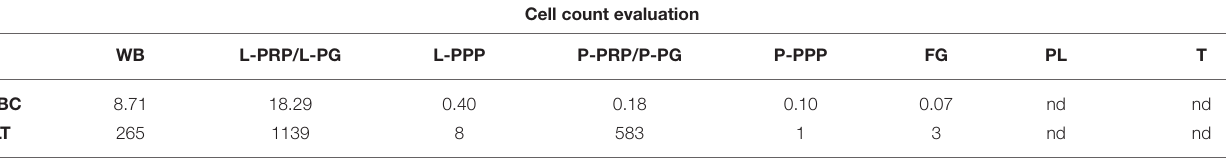
TABLE 1 | Leukocyte and platelet concentrations obtained from whole blood (pool of 250ml from five dogs) and each hemo-component. Cell count evaluation